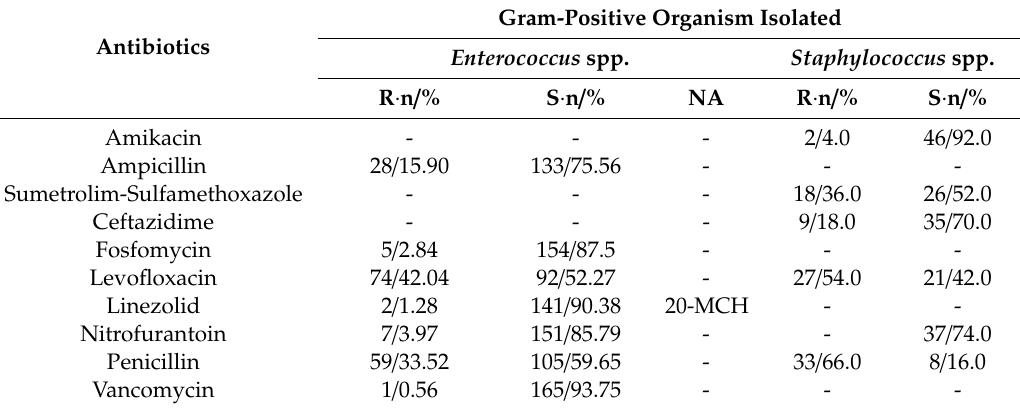
Table 4. Overall antibiotic resistance profile in Gram-negative